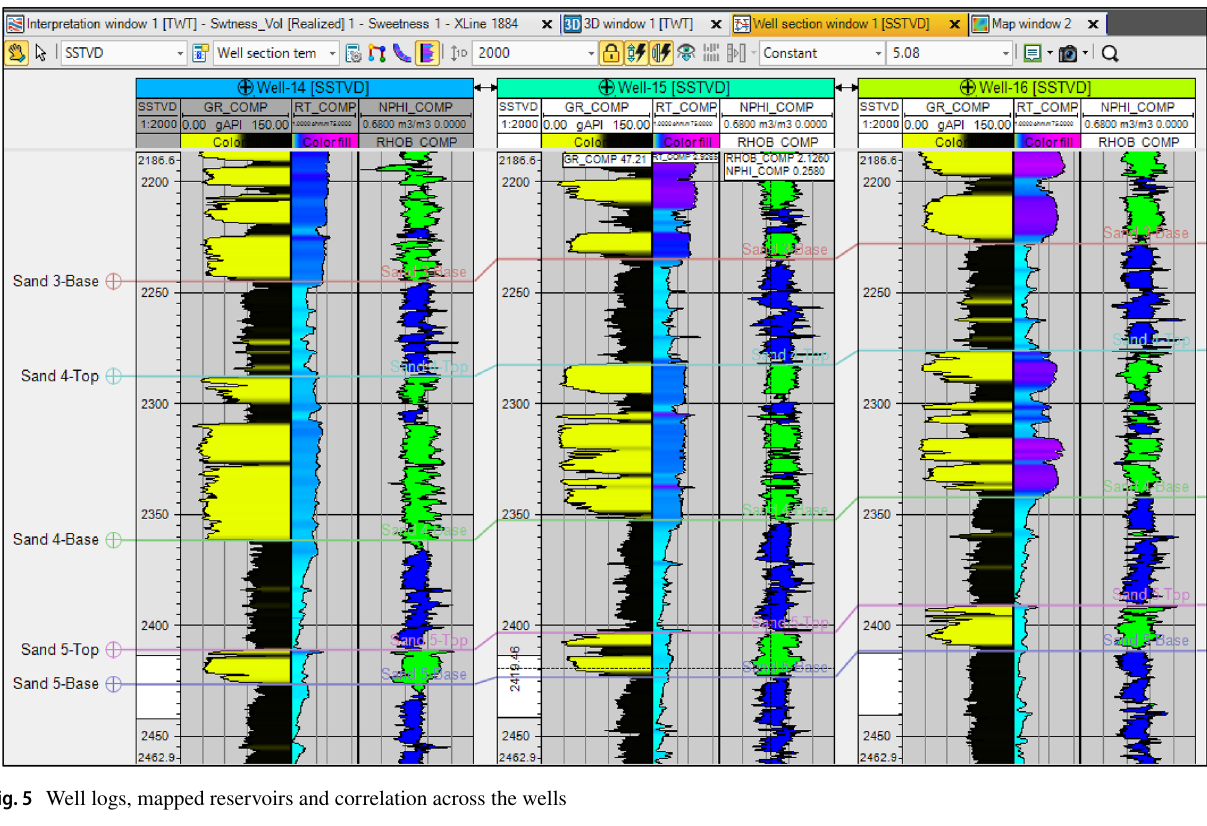
Fig. 5 Well logs, mapped reservoirs and correlation across the wells